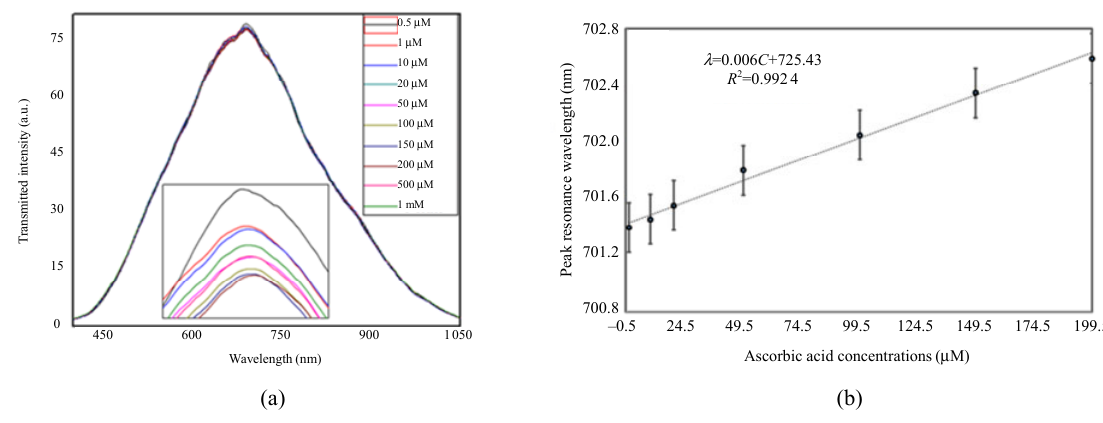
Fig. 12 LSPR sensing of Probe I: (a) transmitted intensity spectra and (b) linearity response of sensor.